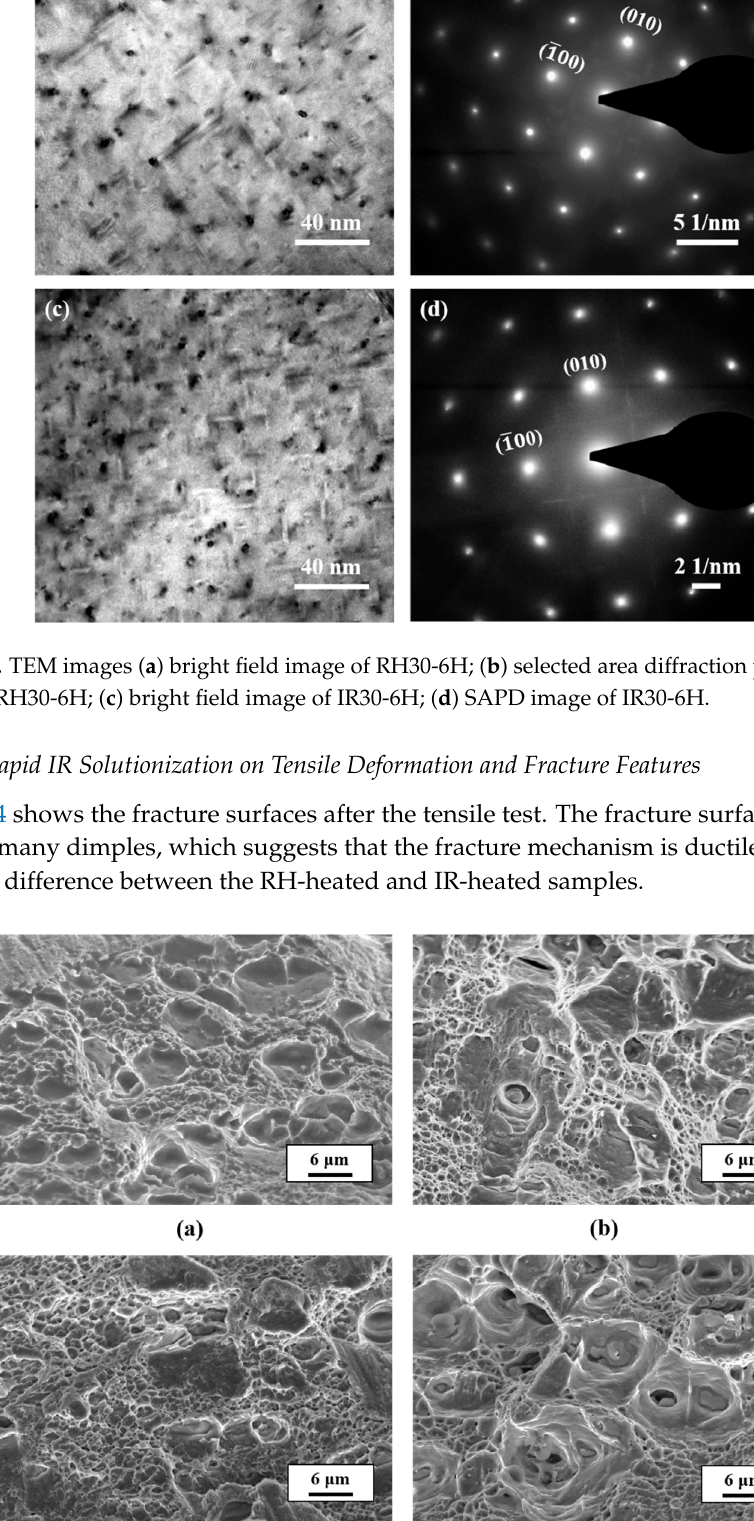
Figure 14. Fracture images of ( a ) RH30; ( b ) IR30; ( c ) RH30-6H; and ( d ) IR30-6H.